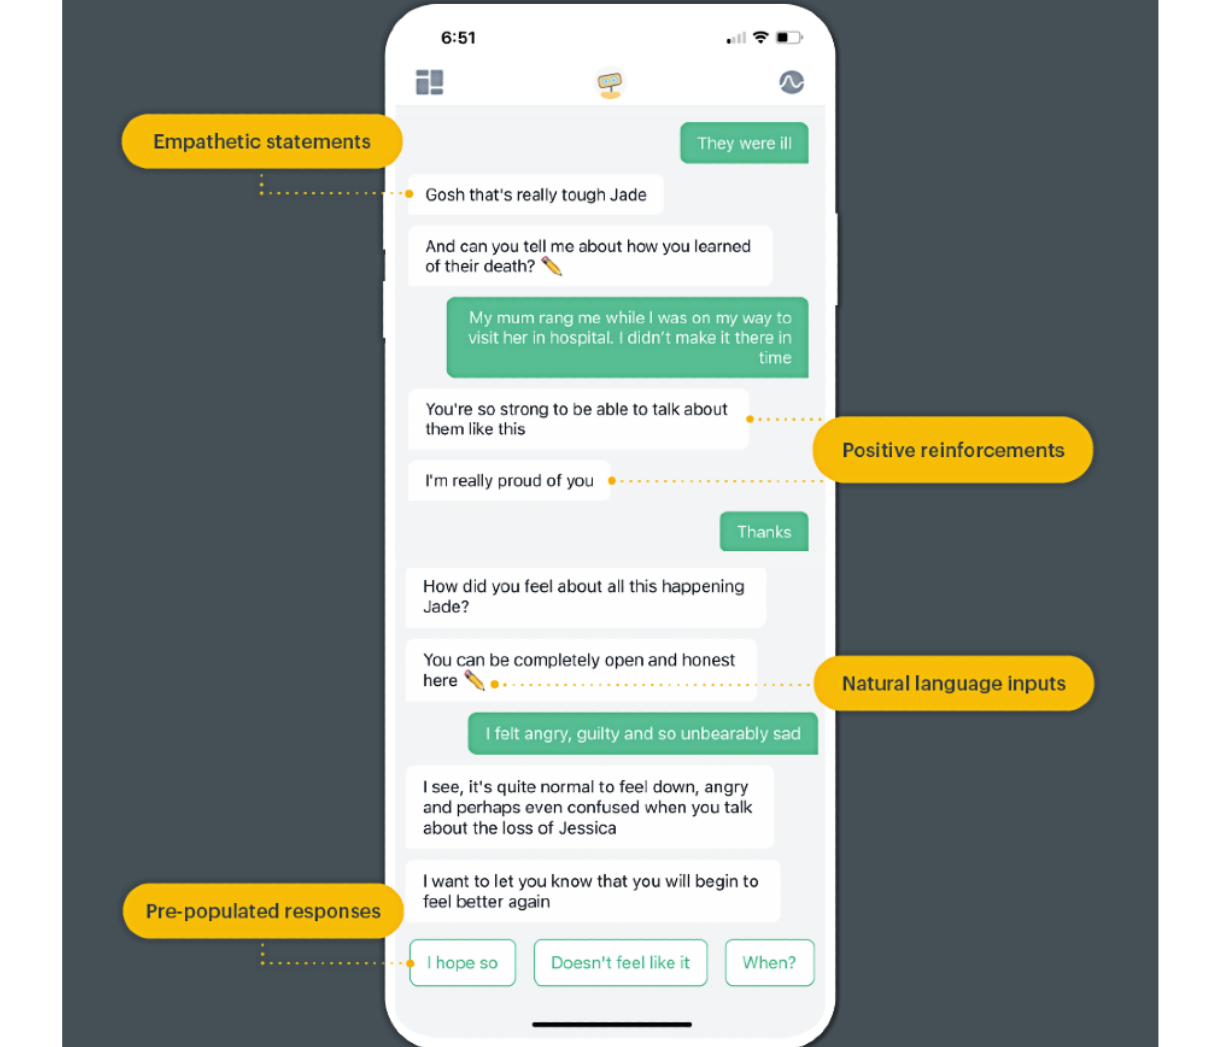
Figure 1. Screenshot of an example interaction with Woebot about